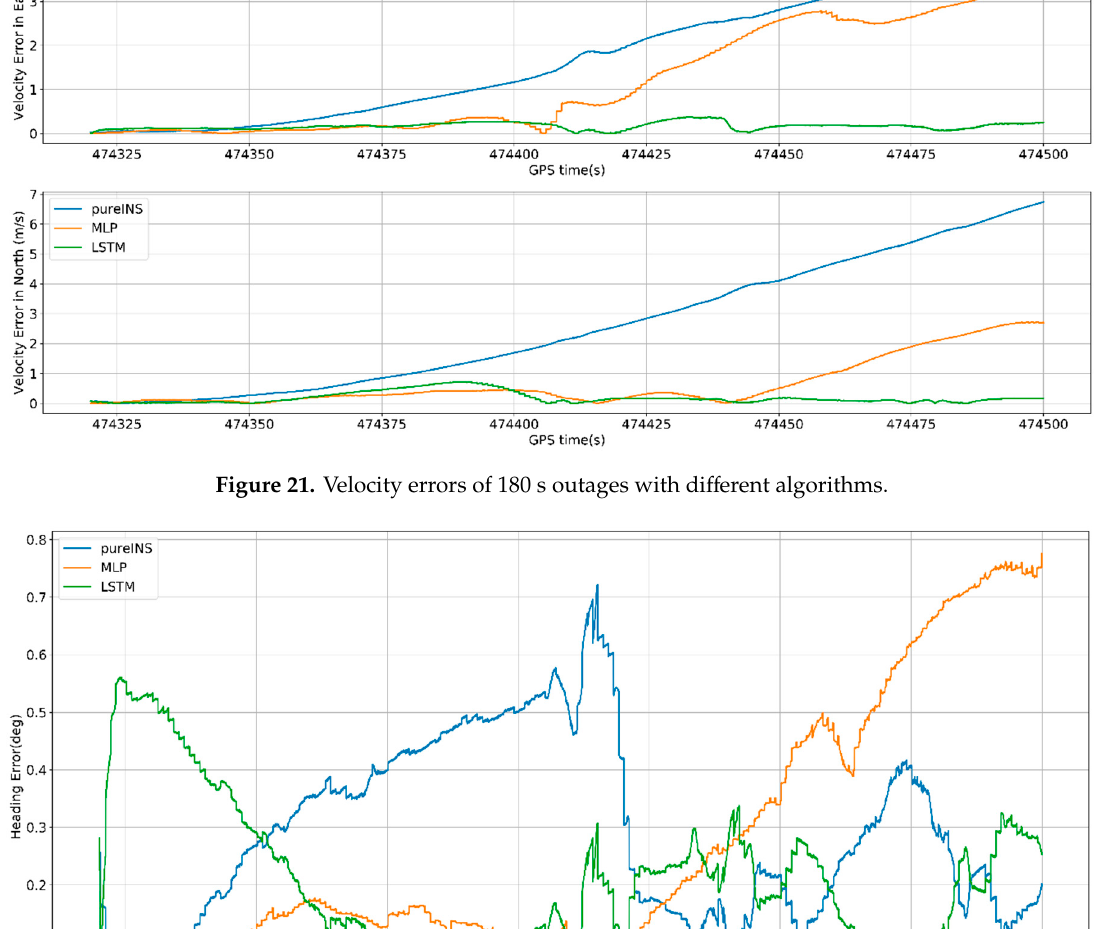
Figure 20. Position errors of 180 s outages with different algorithms.